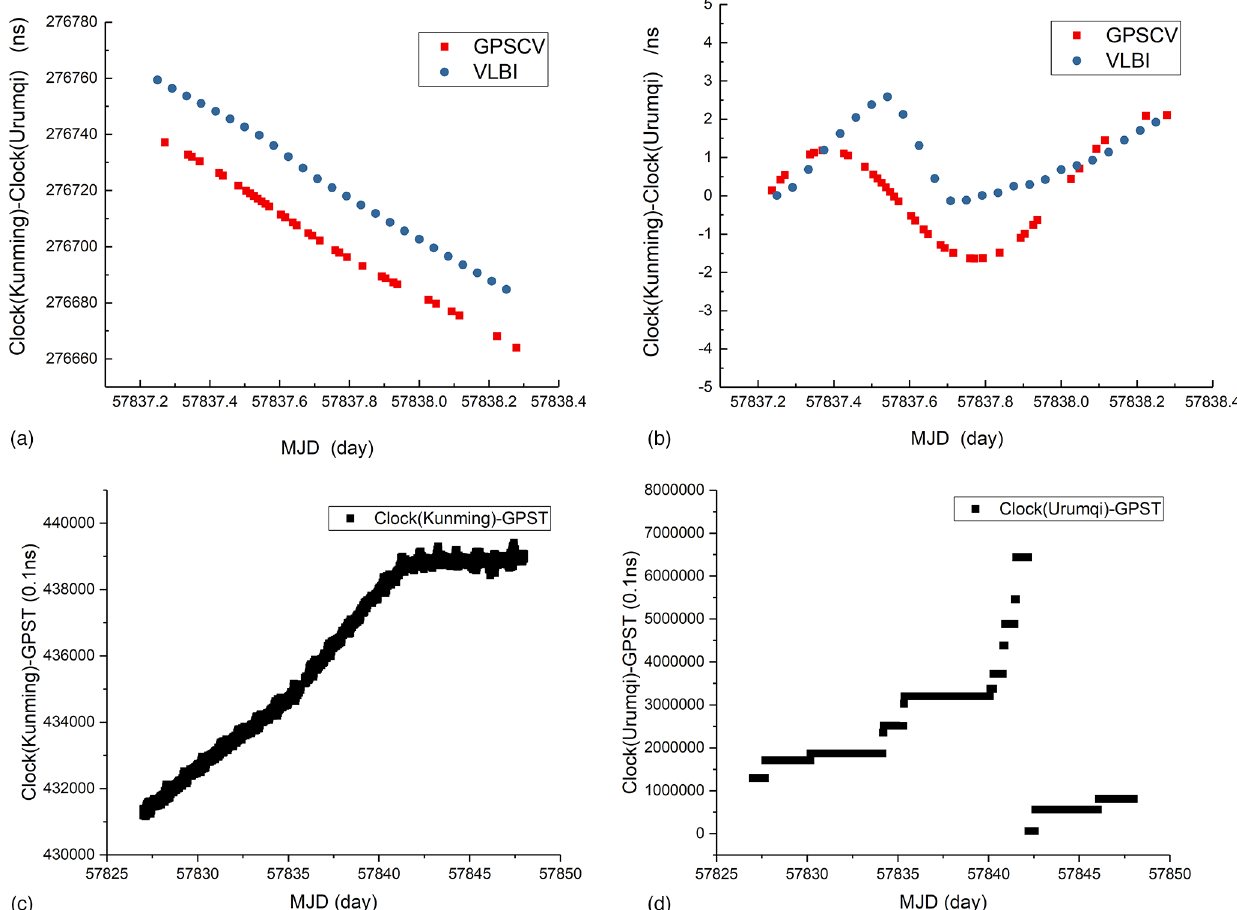
Fig. 7. Clock differences at the Kunming and Urumqi stations in MJD57837. (a) Clock differences between calculations based on GPS CV and VLBI. (b) Clock difference series after removing the linear trend. (c) Clock difference series between the Kunming station clock and GPST across 20 days surrounding MJD57837. (d) Clock difference series between the Urumqi station clock and GPST across 20 days surrounding